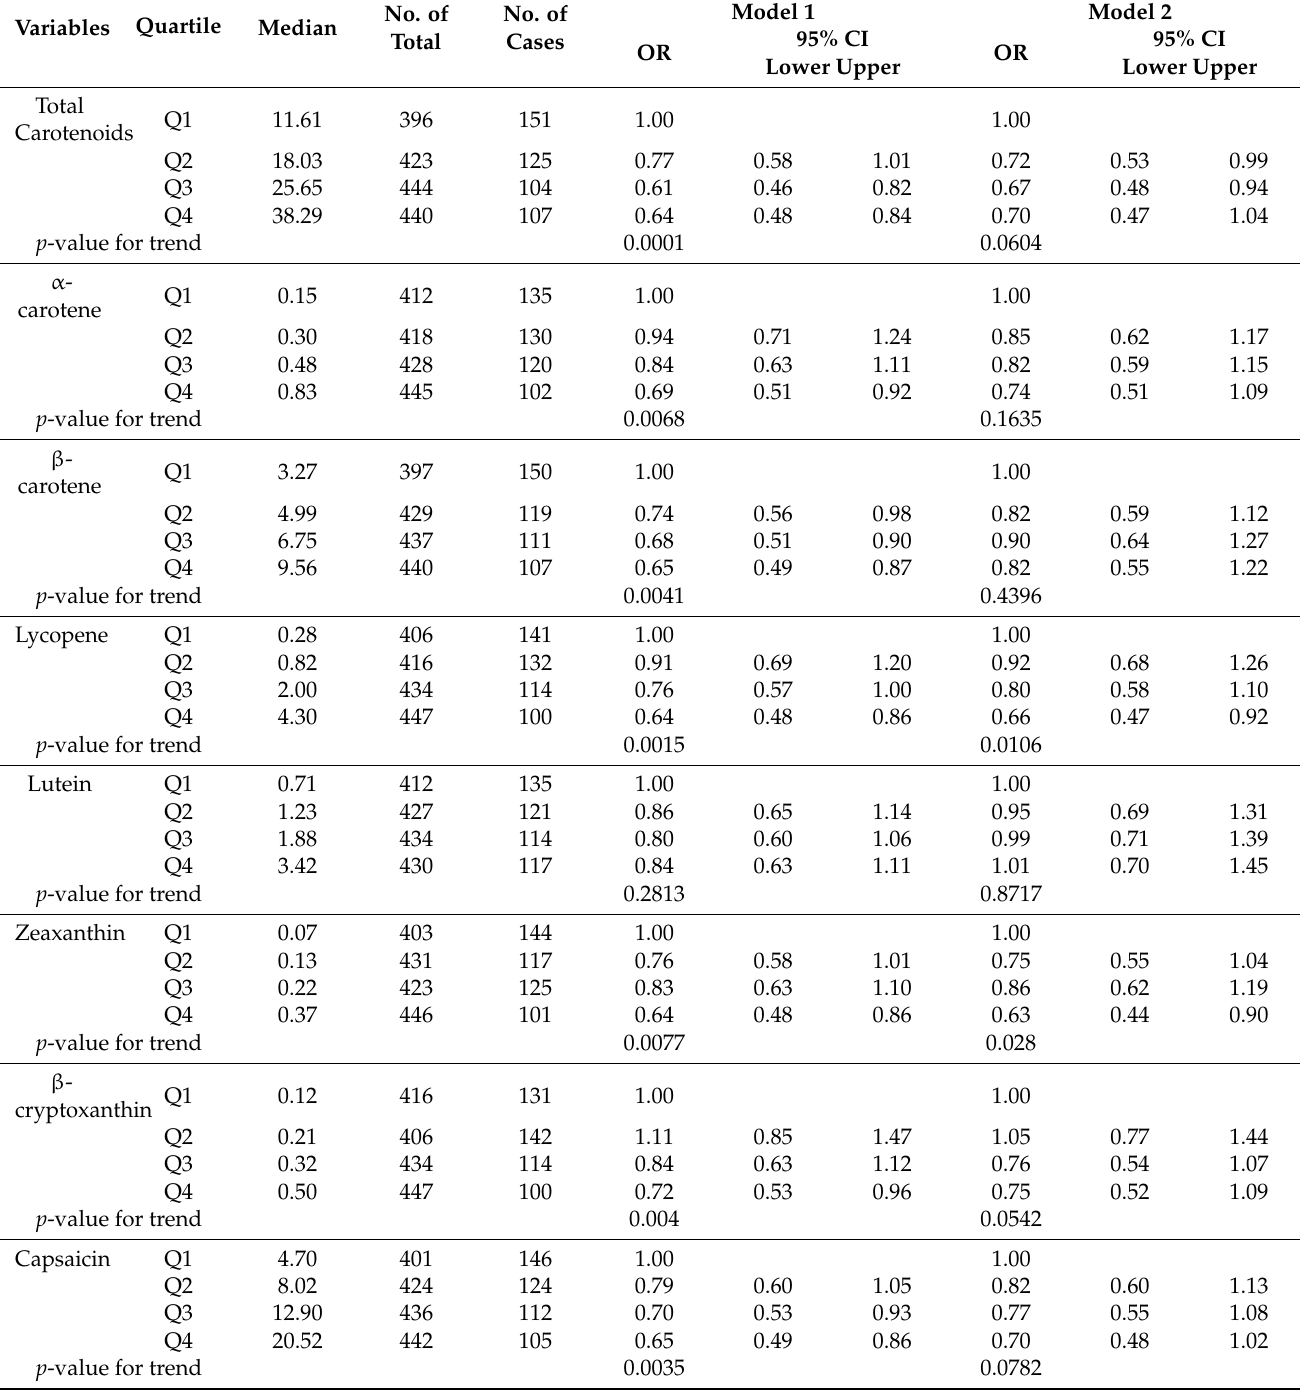
Table 5. Association between total carotenoid and carotenoid subclass intake and prevalence of depressive symptoms in multivariate-adjusted logistic regression